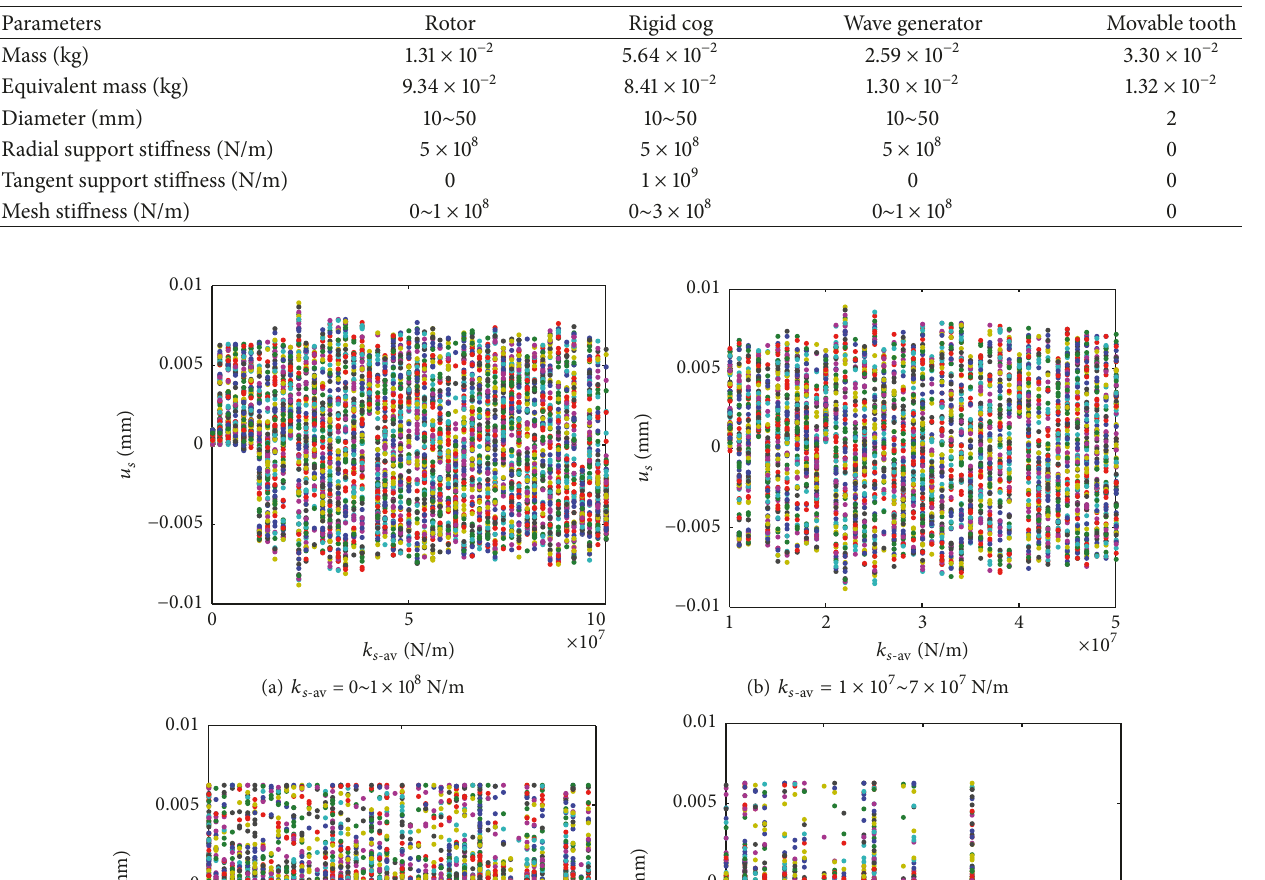
Table 1: Parameters of example system.